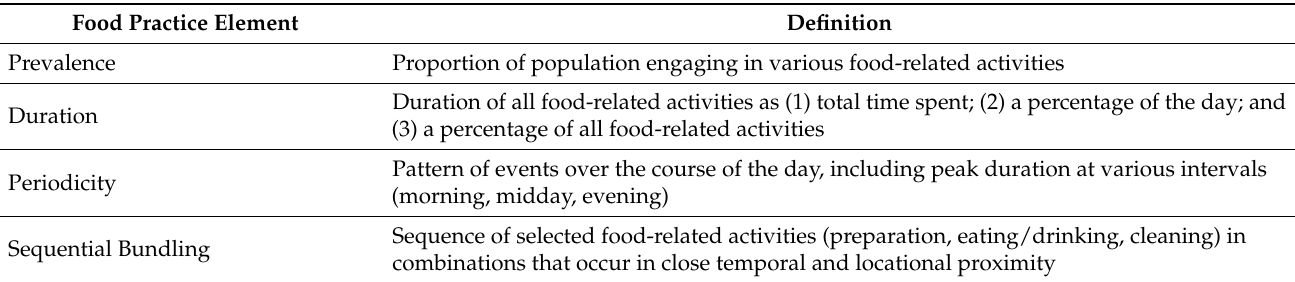
Table 1. Key Food Practice